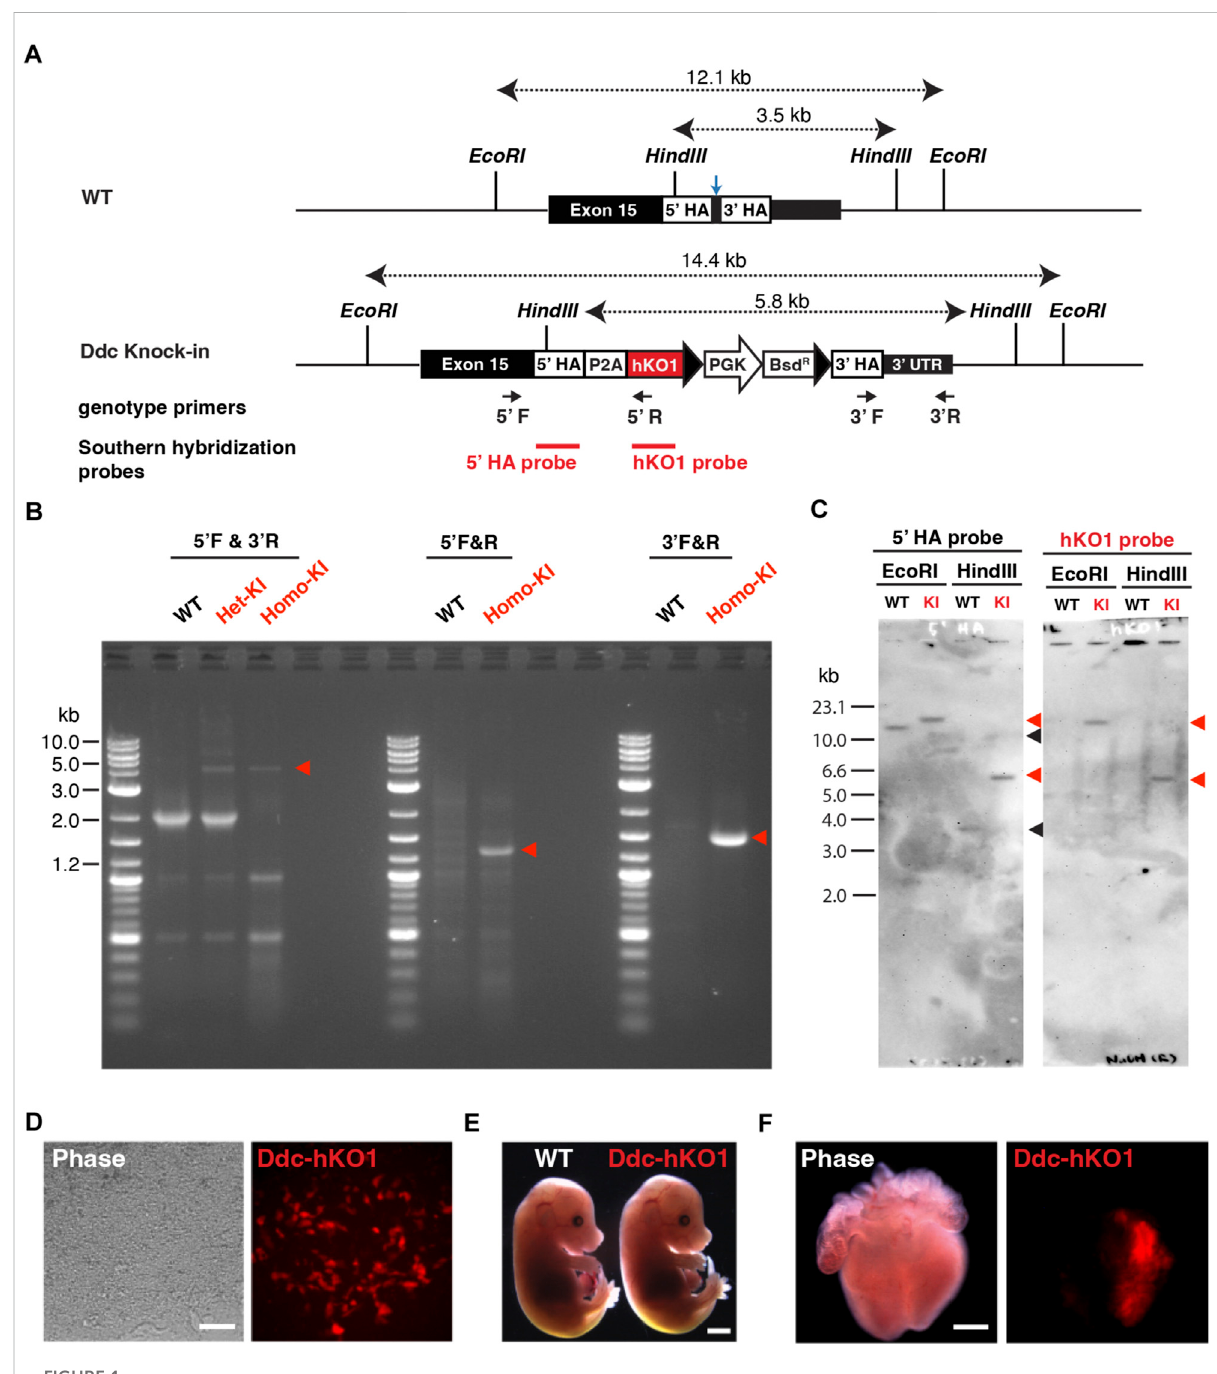
FIGURE 1 Establishment of Ddc-hKO1 knock-in reporter mice. (A) Schematic representation of Ddc-hKO1 knock-in strategy at dopa-decarboxylase ( Ddc ) locus. Arrows indicate the PCR primer sets for the genotyping of the knock-in site. Blue arrow indicates the targeted site of sgRNA. (B) Representative results of PCR-based genotyping of wild type, and Ddc-hKO1 knock-in embryonic stem cells (ESC) and mouse. The positions of the primerswereindicatedin (A) .Redarrowheadsindicatetheexpectedsizeofampliconcontainingknock-incassette.DNAladdersizeisindicated on the left side of the fi gure. WT, wild type; Het-KI, Ddc-hKO1 heterozygous ESC; Homo-KI, Ddc-hKO1 homozygous mouse. (C) Southern hybridization analysis of Ddc-hKO1 homozygous mouse. Red arrowheads indicate the expected band size of knock-in allele, and black arrowheads indicate the expected band size of wildtype allele. Ladder size is indicated on the left side of the fi gure. WT, wild type; KI, Ddc-hKO1 homozygous mouse. (D) Representative images of cardiac cell lineages differentiated from the knock-in heterozygous ESCs. Scale bar, 50 μ m. (E) Representative images of E18.5 embryos of WT and Ddc-hKO1 homozygous mice. Scale bar, 2 mm. (F) Representative images of E15.5 embryonic heart of Ddc- hKO1 homozygous mouse. Scale bar, 500 μ